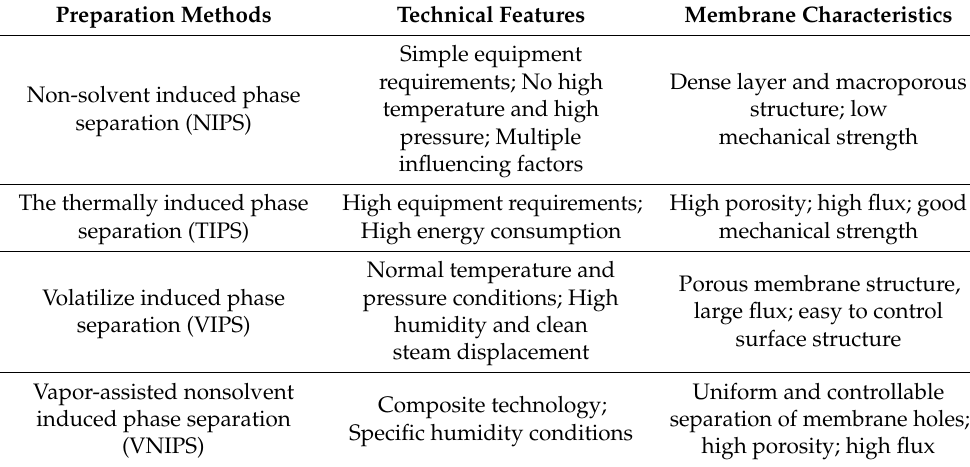
Table 1. Performance comparison of different membrane preparation